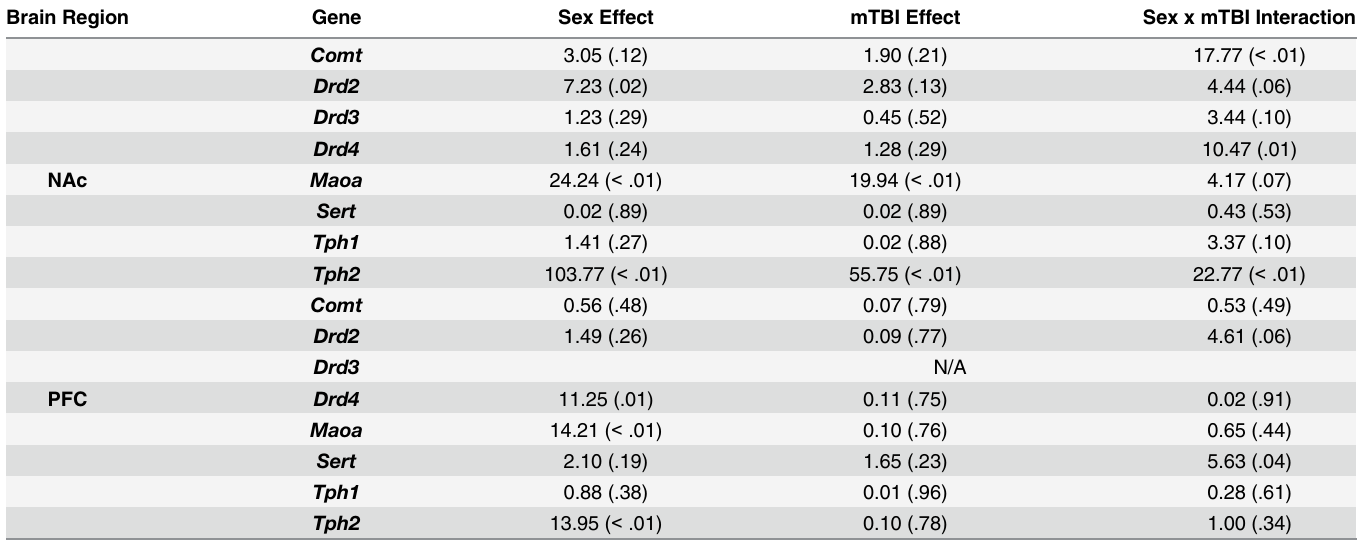
Table 2. Summary of results from the two-way ANOVAs for changes in expression of each of the genes examined in the NAc and PFC of animals with a sham or mTBI F(p). Brain Region